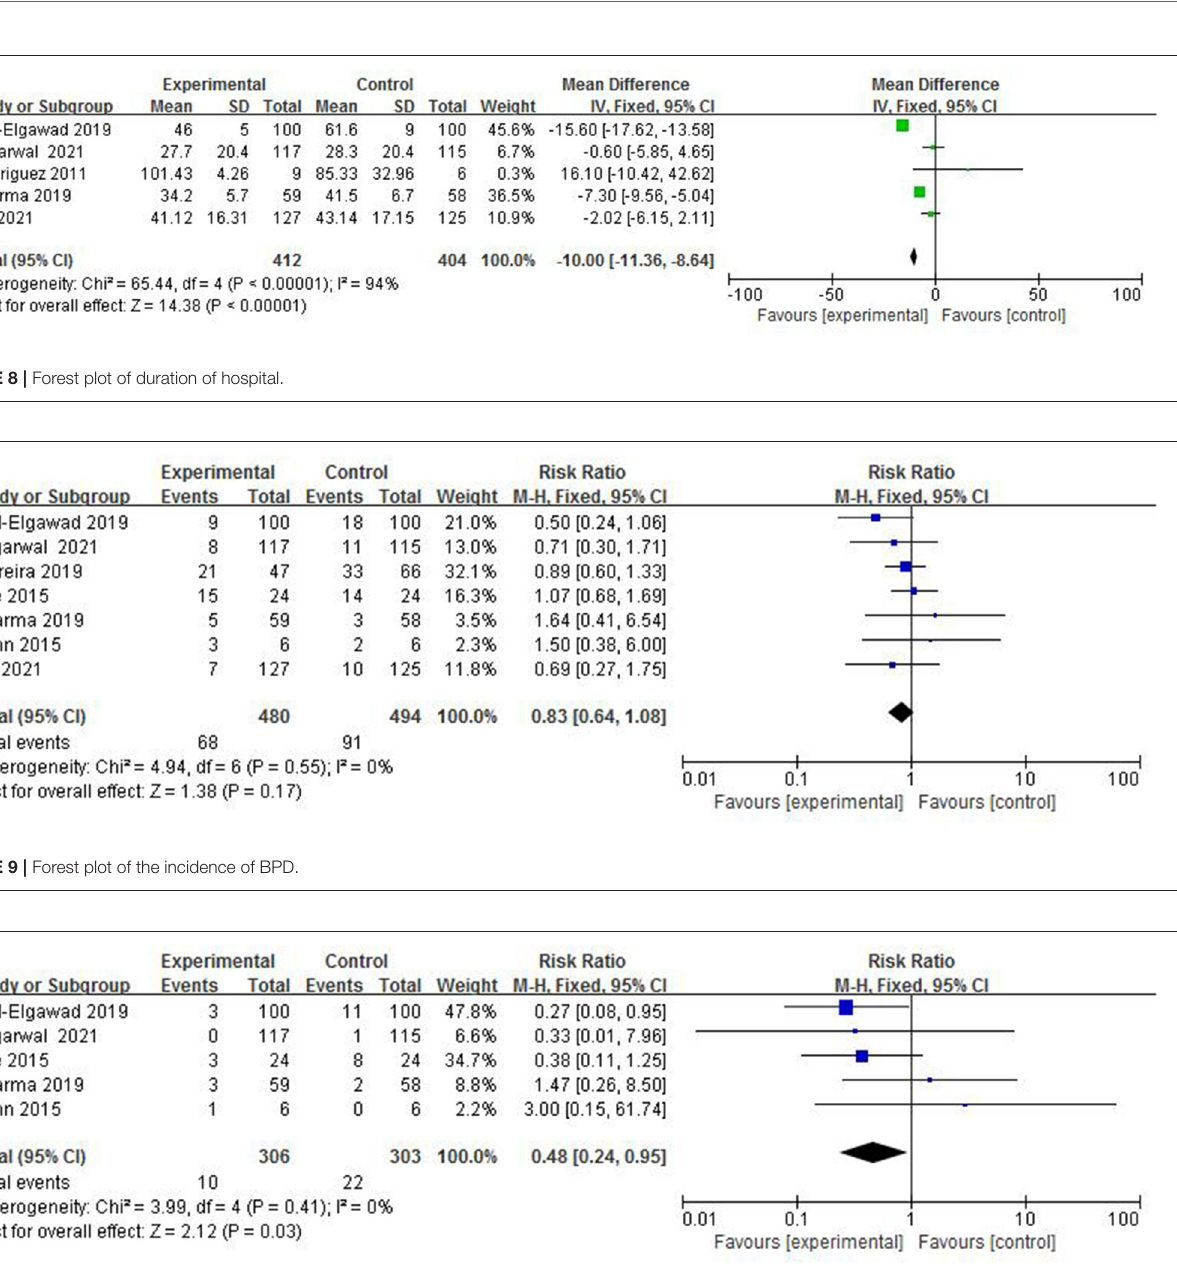
FIGURE 10 | Forest plot of the incidence of